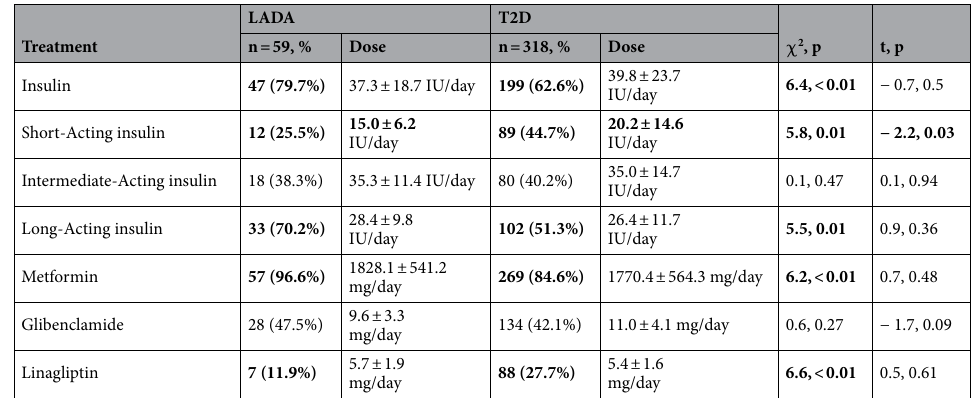
Table 2. Diabetes therapy in patients with LADA and T2D. Significant values are in [bold]. LADA, Latent autoimmune diabetes in adults; T2D, Type 2 diabetes. We used Chi-squared test for categorical variables, and t-Student test for numerical data. A p-value < 0.05 was considered as